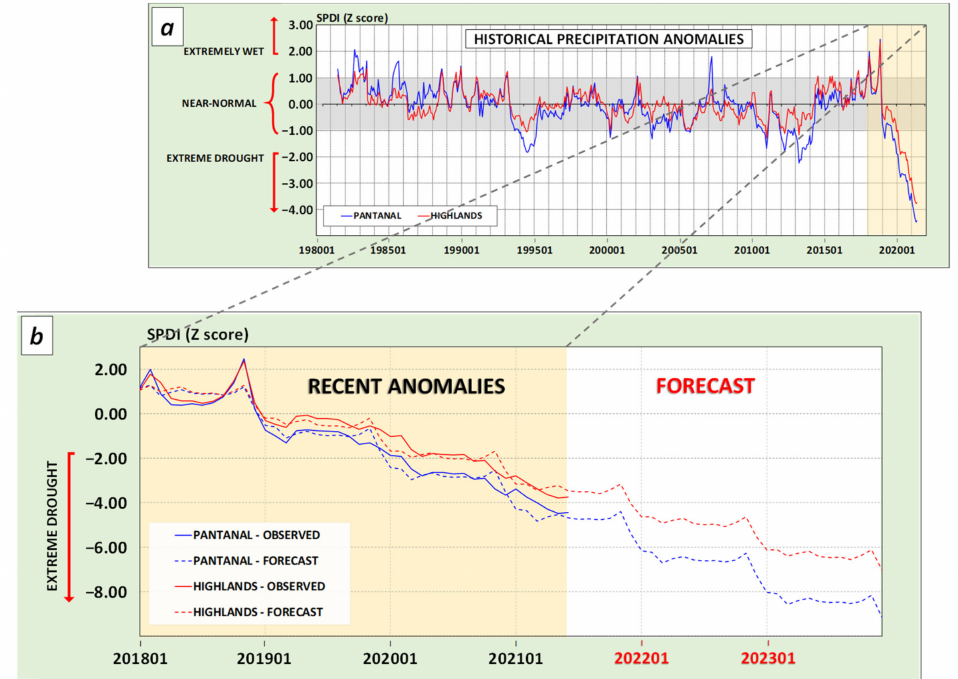
Figure 12. ( a ) Observed recent precipitation anomalies (as SPDI) for the series January 1981–June 2021 at the Pantanal and the surrounding Highlands. ( b ) Recent precipitation anomalies and time series forecasting for January 2021 to December 2023 by means of the Exponential Triple Smoothing